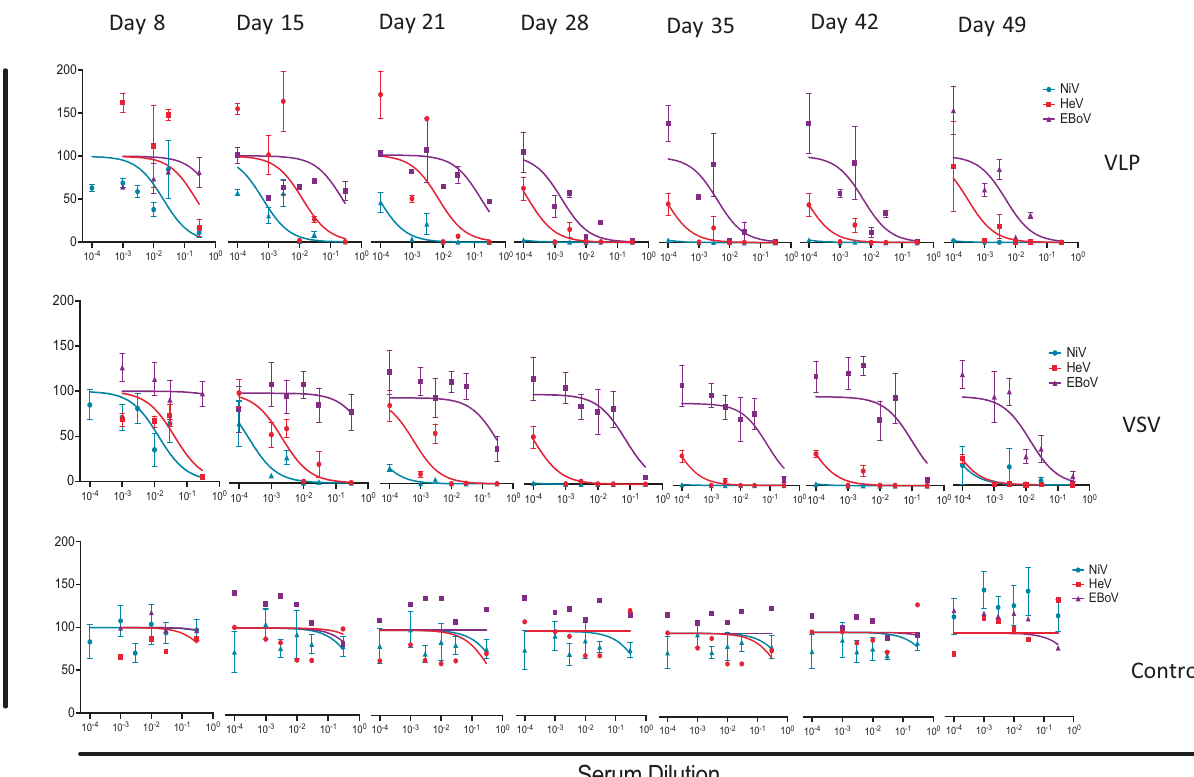
Fig. 7 Multivalent pseudotyped VSV and VLPs elicited time-dependent neutralizing antibody titers. Neutralization tests were performed for individual hamsters, and the results shown are averages of individual hamster sera. Sera from pseudotyped VSV and VLP-vaccinated hamsters and control groups were analyzed for eight time points and data normalized to day 0. Error bars represent standard deviation.